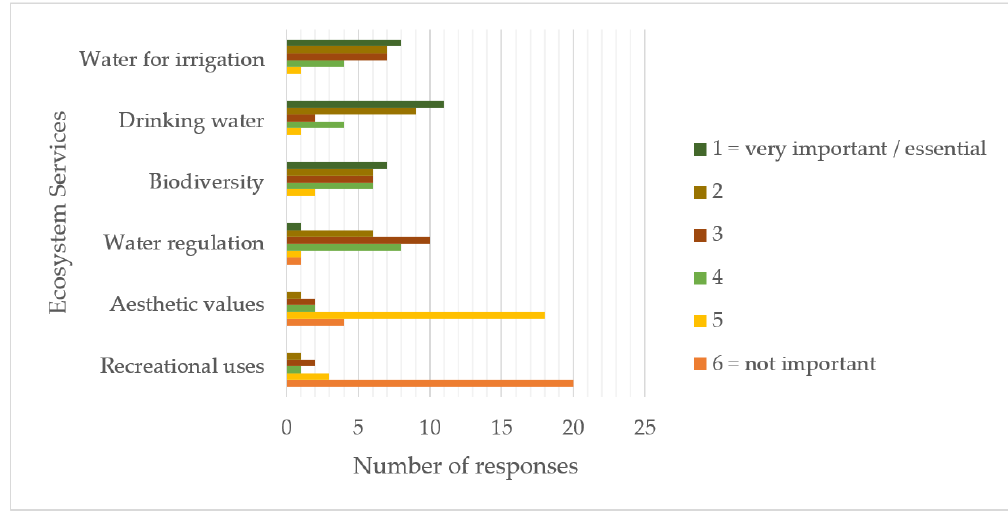
Figure 3. Perceived importance of water ecosystem services among stakeholders.